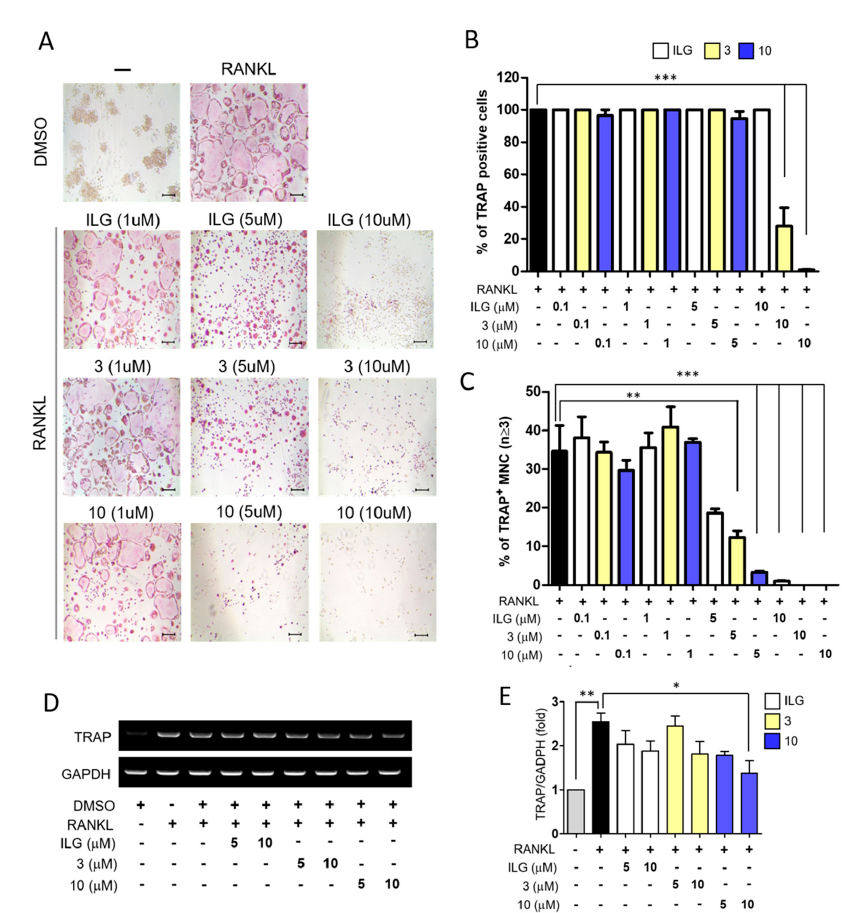
Figure 2. Isoliquiritigenin (ILG) and ILG derivatives suppress RANKL-induced osteoclast differentiation in RAW264.7 cells. RAW264.7 cells were treated with 40 ng/mL RANKL in the presence of ILG or ILG derivatives for 4 days. ( A ) RAW264.7 cells were treated with 1, 5, and 10 μ M of ILG or ILG derivatives. The fixed cells were stained for TRAP and observed under a light microscope (40×) to determine TRAP positive cells. Scale bar = 400 μ m. ( B ) Number of TRAP stained cells and ( C ) TRAP-positive multinuclear cells (3 or more nuclei) were counted as osteoclast cells. ( D ) mRNA level of TRAP was examined by RT-PCR. ( E ) The RT-PCR results were normalized to GAPDH. * p < 0.05, ** p < 0.01 ( n ≥ 3).